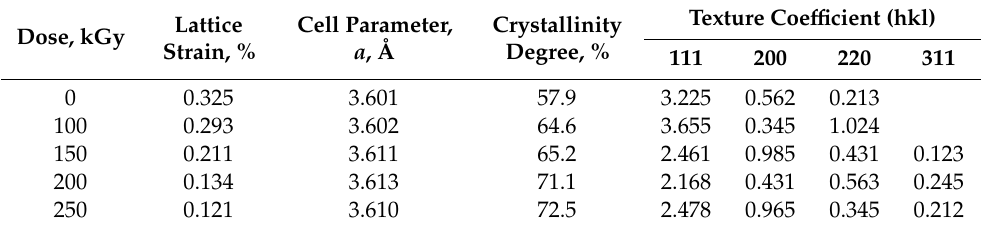
Table 1. XRD parameters of the pristine and e-beam treated PET track-etched membranes (TeMs) with embedded copper nanotubes (NTs).